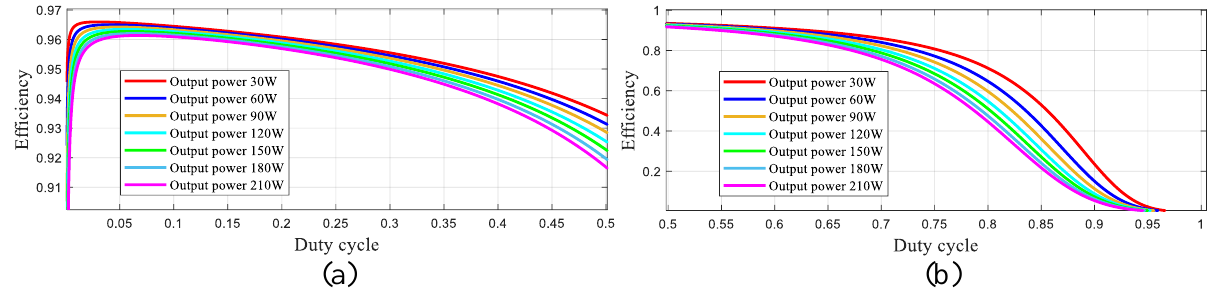
Figure 8. The efficiency of the proposed converter for the various values of the output power, ( a ) while the duty cycle varied from 0 to 50 percent, and ( b ) while the duty cycle varied from 50 to 100